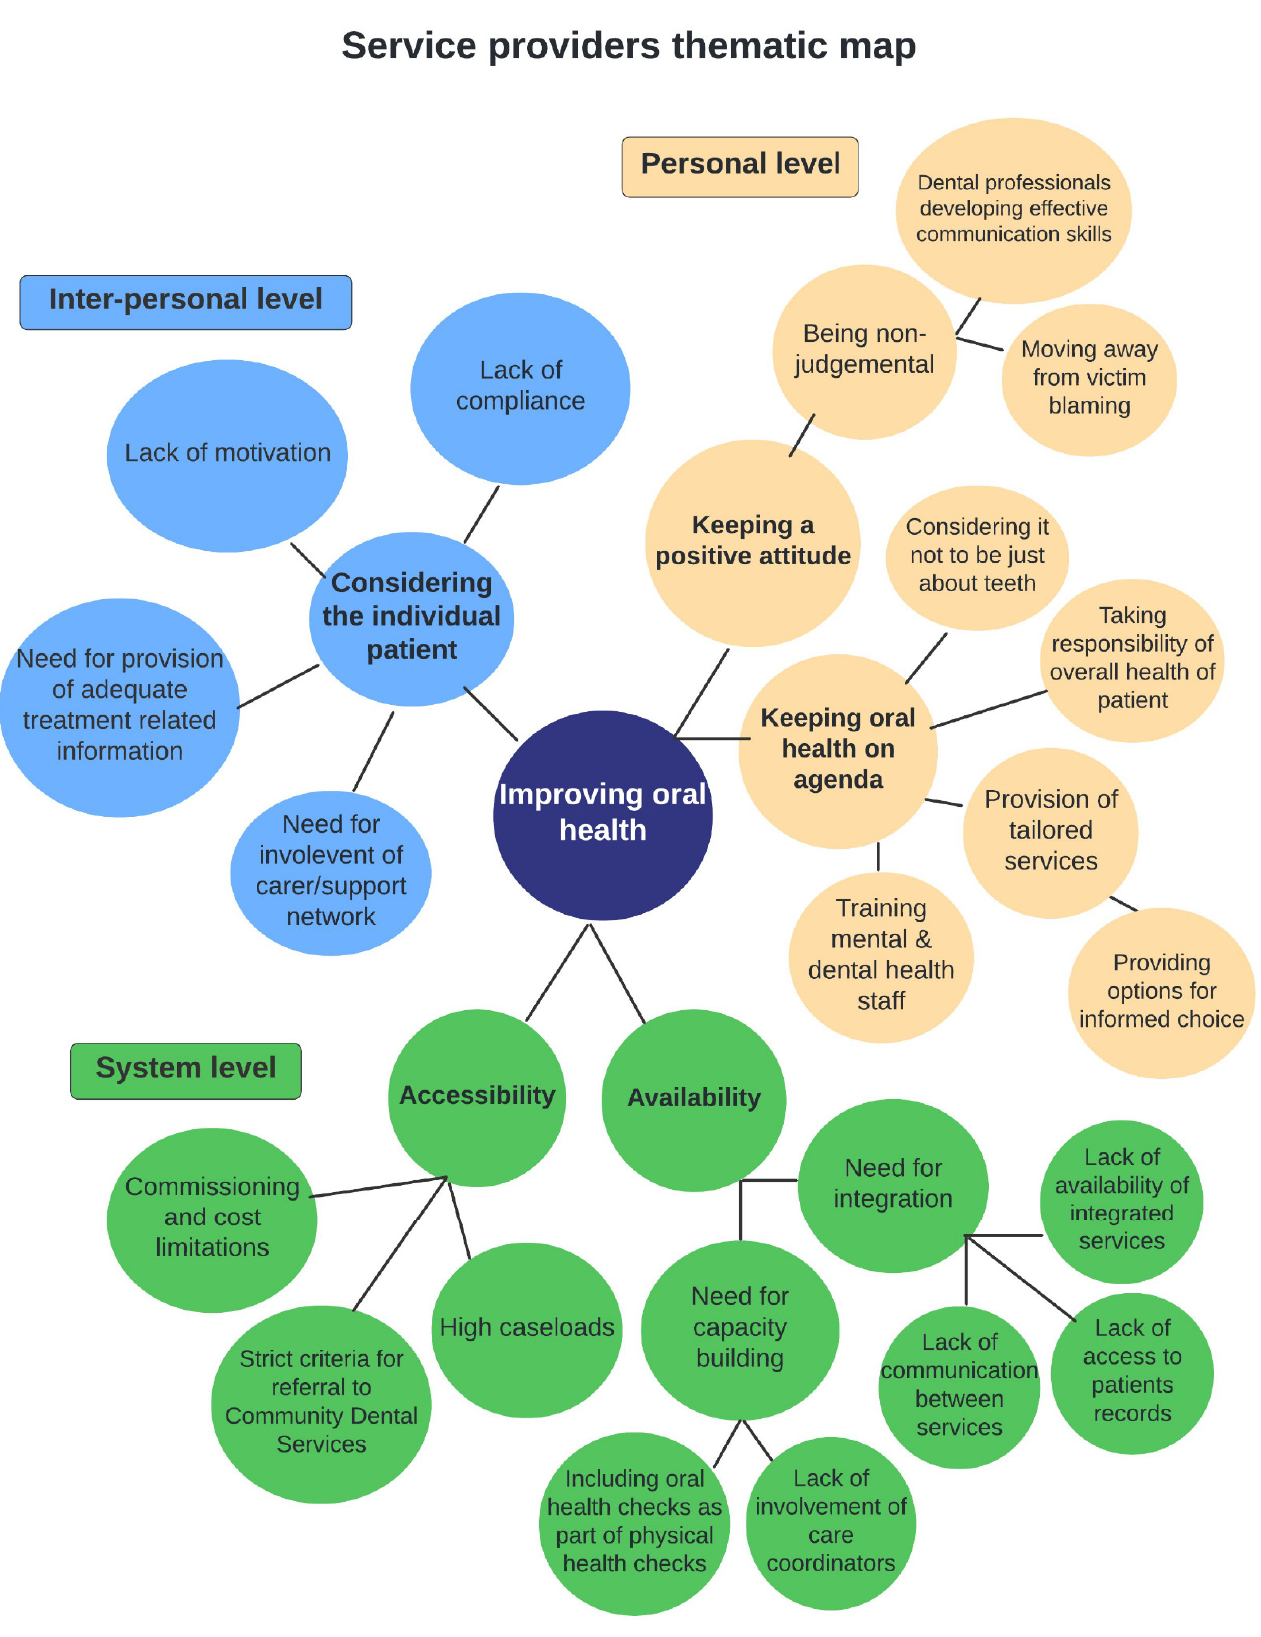
Figure 2. Thematic map of service providers’ perspectives on barriers and recommendations for improving oral health in people with severe mental illness at personal, inter-personal and system levels. CDS: Community Dental